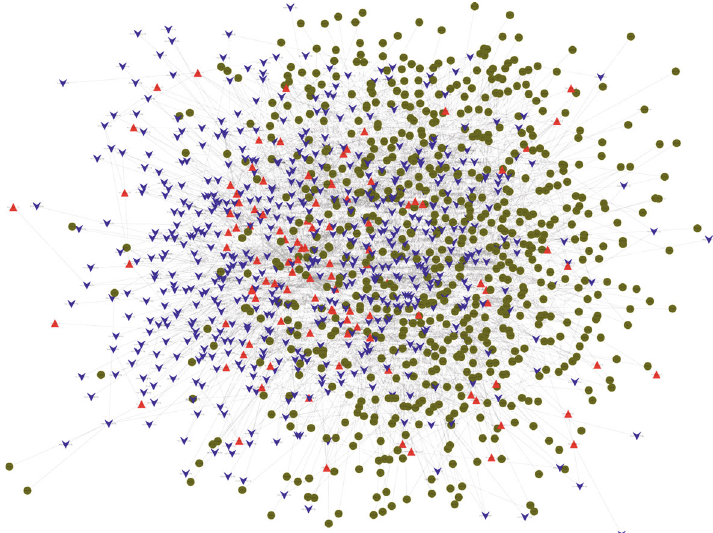
Figure 6: circRNA-miRNA-mRNA regulatory network analysis. Red triangles, blue arrows, and dark green circles represent DECs, harbored miRNAs, and targeted mRNAs,